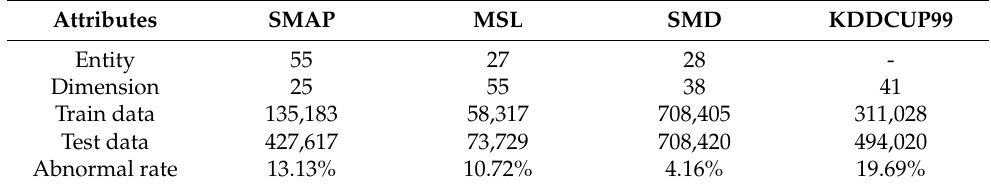
Table 1. Summary of dataset